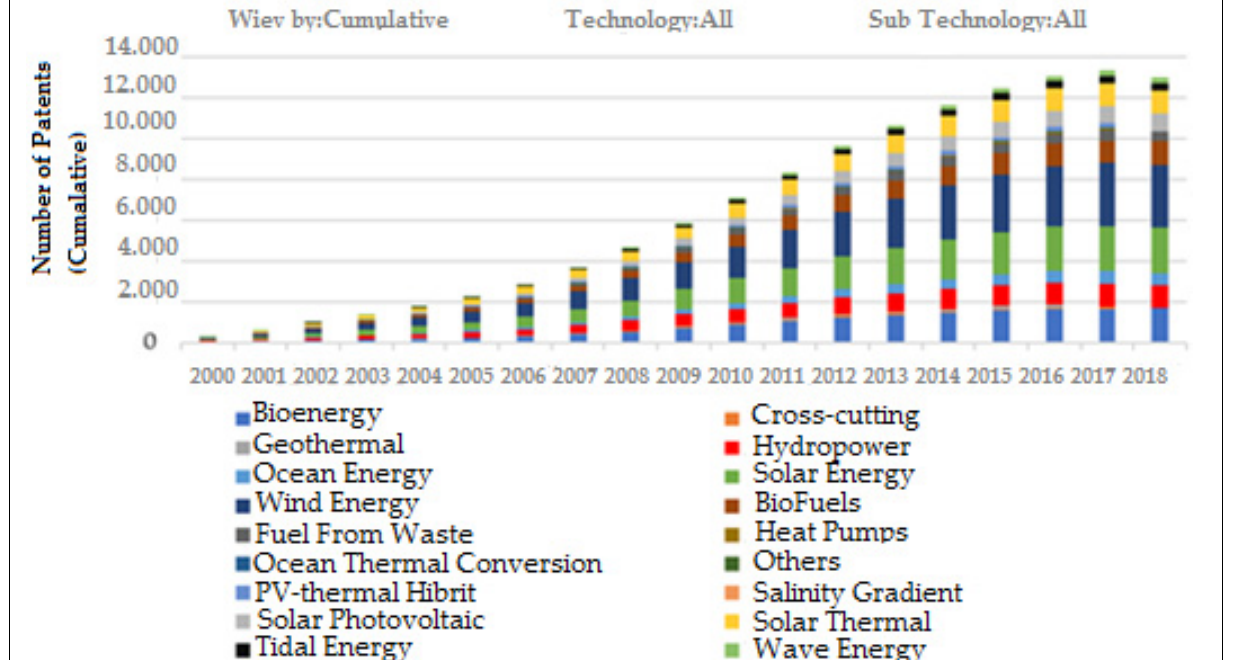
Figure 4. The energy technology mix in Russia. Source: [44].